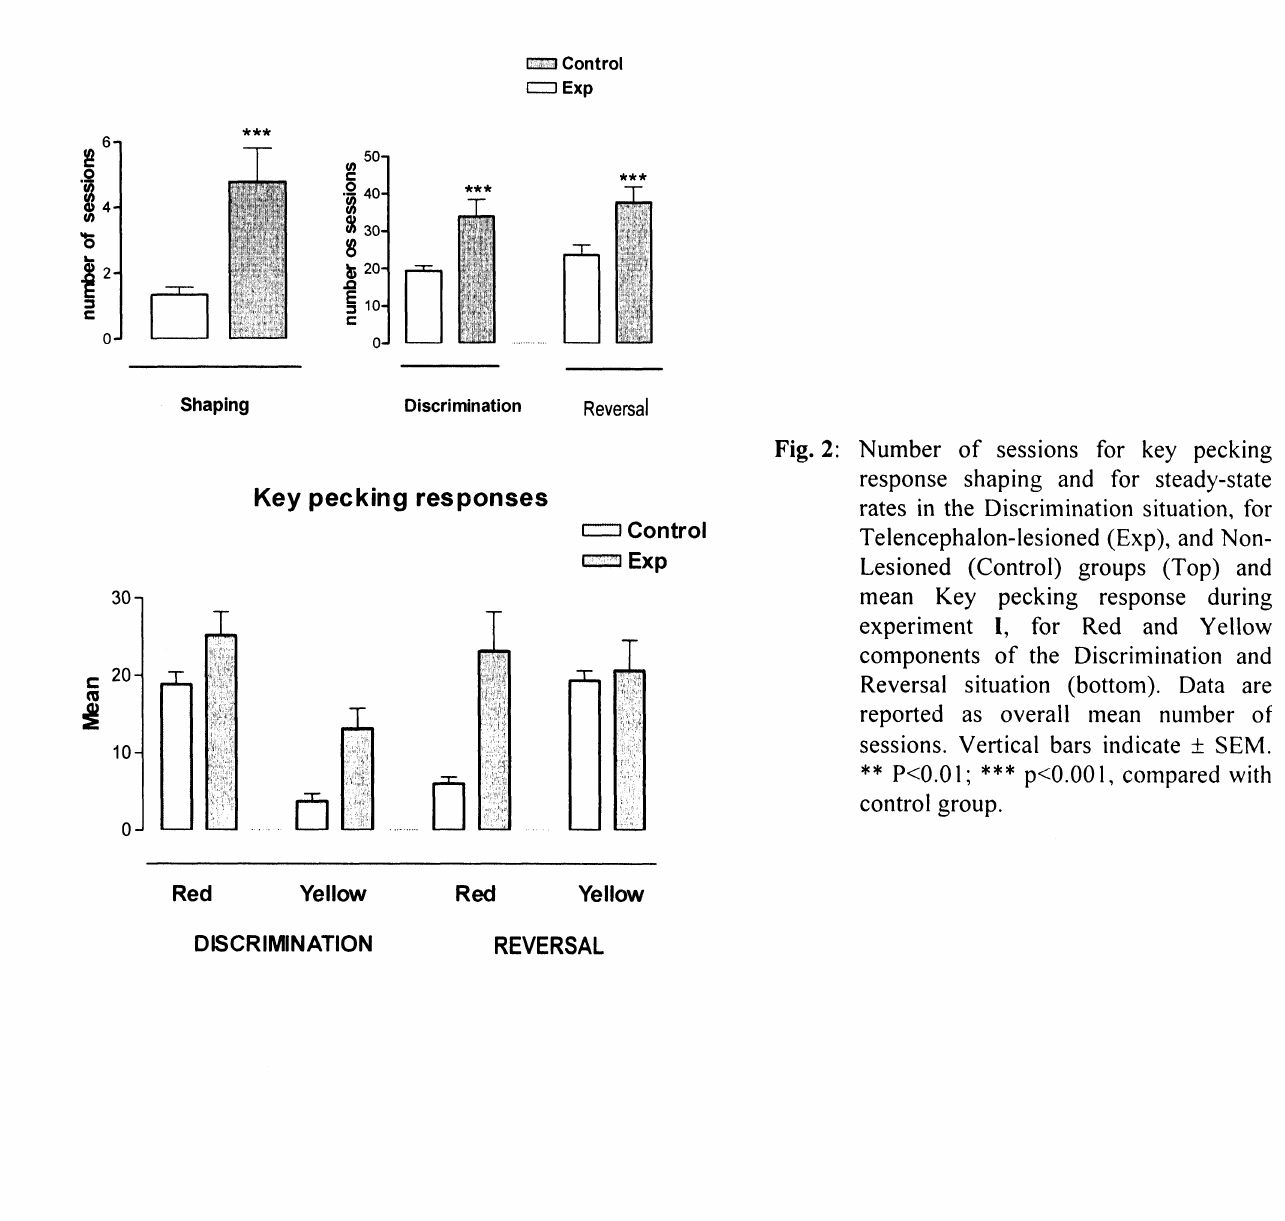
Fig. 2: Number of sessions for key pecking response shaping and for steady-state rates in the Discrimination situation, for Yelencephalon-lesioned (Exp), and Non- Lesioned (Control) groups (Top) and mean Key pecking response during experiment 1, for Red and Yellow components of the Discrimination and Reversal situation (bottom). Data are reported as overall mean number of sessions. Vertical bars indicate + SEM. ** P<0.01; *** p<0.001, compared with control